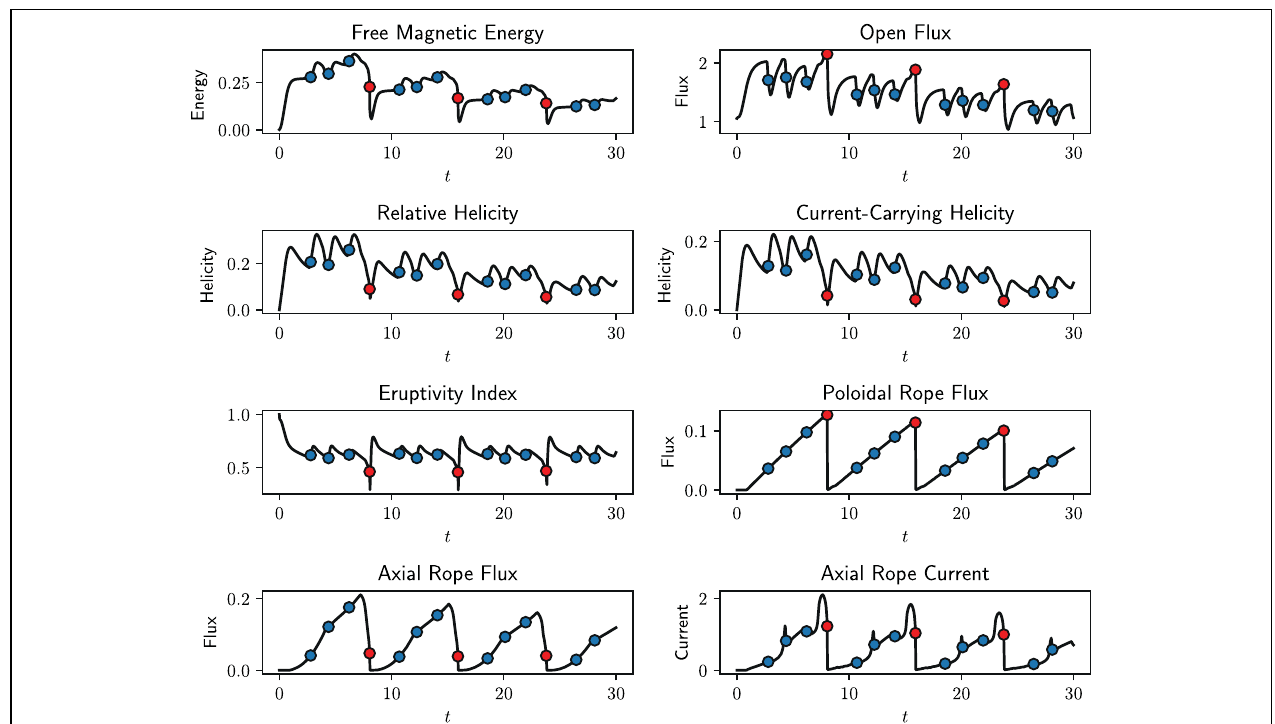
FIGURE 6 | A selection of diagnostics for a simulation exhibiting flux rope eruptions (red circles) interspersed with multiple arcade eruptions (blue circles). In this simulation, η